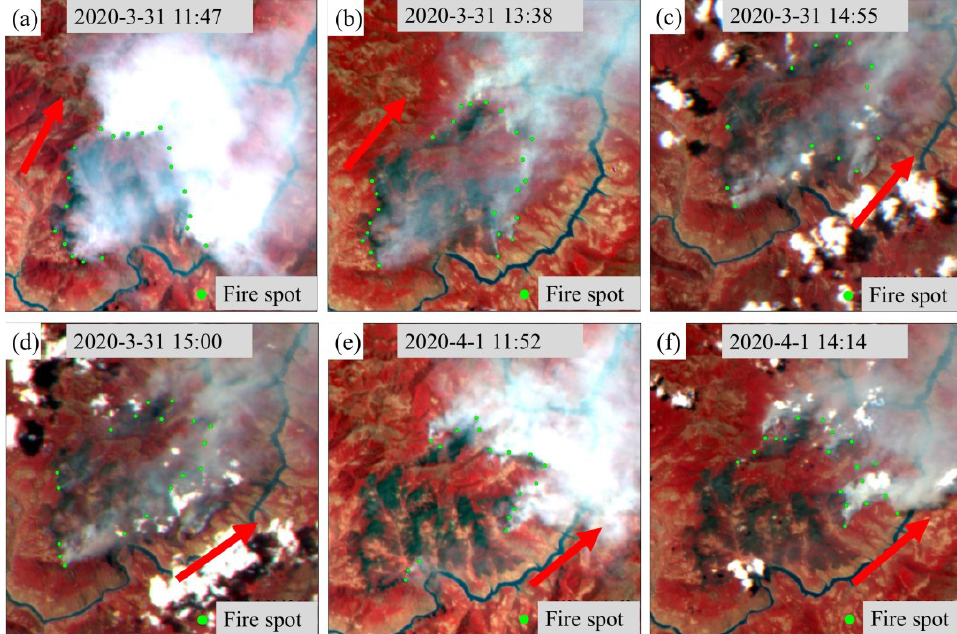
Figure 3. Forest fire monitoring in Muli County based on GF-4 satellite data. ( a – f ) are the fire and smoke distribution at 11:47 a.m. on 31 March, 13:38 p.m. on 31 March, 14:55 p.m. on 31 March, 15:00 p.m. on 31 March, 11:52 a.m. on 1 April and 14:14 p.m. on 1 April in 2020, respectively. The location and shape of the fire line were extracted from multi-source remote sens- ing data (Figure 4). At 12:45 p.m. on 29 March, the image monitoring indicated that the burned area was 1.05 km 2 (Figure 4a). At 11:45 a.m. on 30 March, the burned area was 8.97 km 2 (Figure 4b), and by 12:30 p.m., the burned area had reached 17.08 km 2 (Figure 4d), within 45 min, and the fire spread by 8.11 km 2 . By 14:05 p.m. on 31 March, the fire burned area reached 106.35 km 2 (Figure 4f). The rapid spread of this stage brought great difficul- ties to the rescue. By 11:35 a.m. on 1 April, the fire burned area was 125.89 km 2 (Figure 4g), and the fire was initially controlled at this timepoint. However, the fire reignited again, due to the sudden change of wind direction and the accelerated wind speed. On 5 April, the fire was controlled and extinguished, and the final burnt area was 209.17 km 2 (Figure 4i).